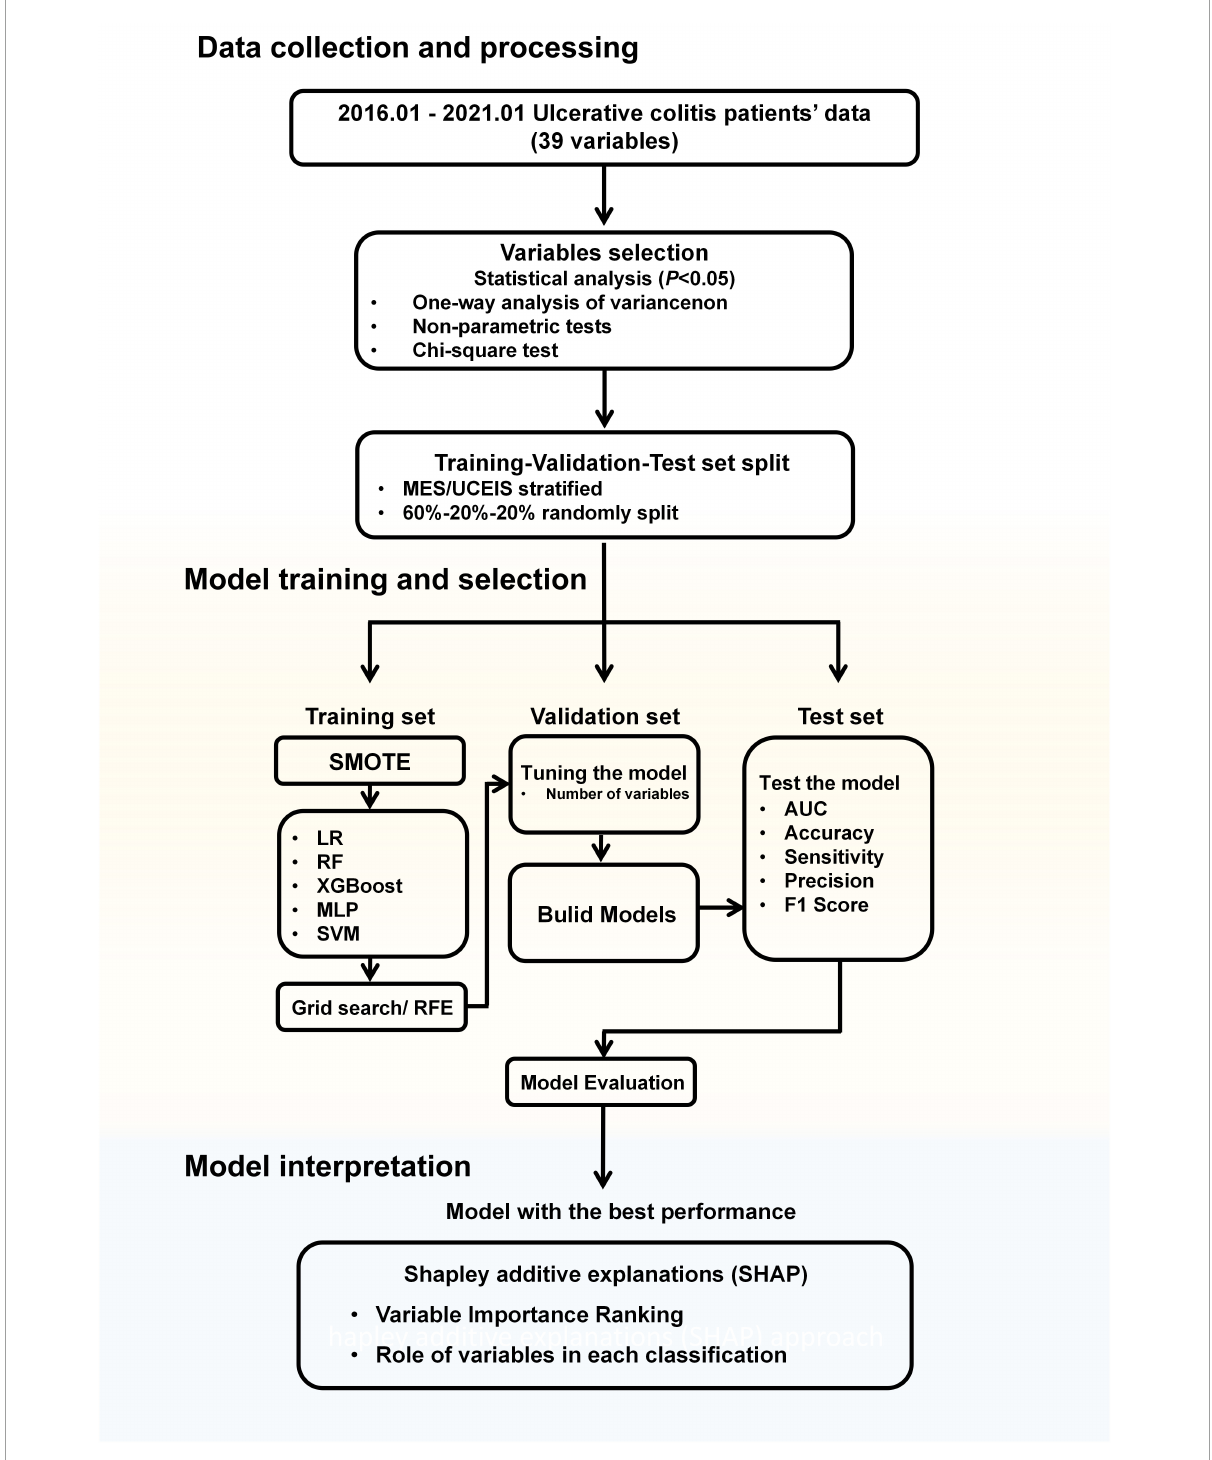
FIGURE1 Workflow diagram. MES, mayo endoscopic subscore; UCEIS, ulcerative colitis endoscopic index of severity; SMOTE, synthetic minority oversampling technique; LR, logistic regression; RF, random forests; XGBoost, extreme gradient boost; MLP, multilayer perceptron; SVM, support vector machine; RFE, recursive feature elimination; AUC, area under the receiver-operating characteristic